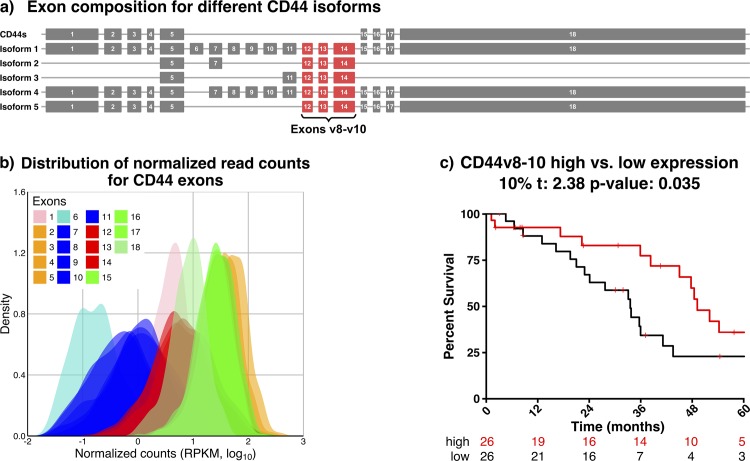
Expression of and survival analysis of CD44 variant 8–10 containing isoforms in the Cancer Genome Atlas Ovarian Serous Cystadenocarcinoma Database.A) Schematic representation of alternative splice isoforms expressing variable exons v8-v10. B) Distribution of RNAseq2 expression data over 254 samples for all CD44 exons in the TCGA ovarian cancer dataset. Samples with no expression were omitted from this figure. C) Kaplan-Meier plot of the survival curve comparing high and low CD44v8-10 expressing samples and corresponding table with the number of patients at each given time point. We defined the high expressing set (red) and the low expressing set (black) as the samples with the highest and lowest expression respectively using the top/bottom 10% of expressers, with the plot extending to 5 years. Bars represent censored data points.